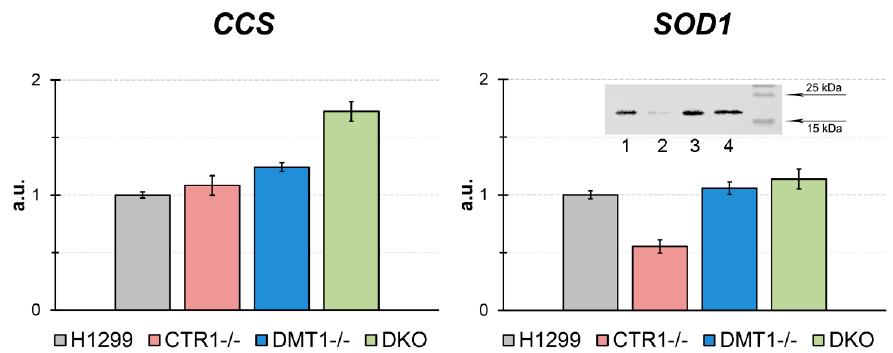
Figure 5. CCS and SOD1 gene expression in the KO cells derived from H1299. Y-axis: mRNA levels (fold over actin). * p < 0.05 compared with H1299. Y-axis: mRNA fold change. Insert: WB for SOD1. 1, H1299; 2, CTR1 KO; 3, DMT1 KO; 4, DKO. Each sample contained 30 µg protein.